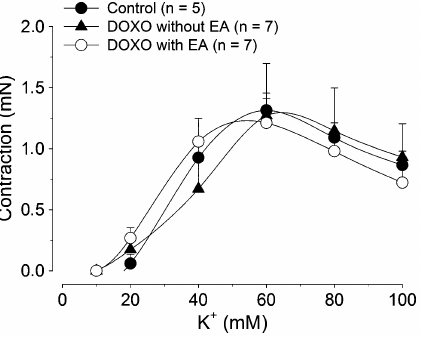
Figure 2. Comparison of the effect of KCl on the distal esophagus of fetus with esophageal atresia (EA). The graph shows the mean tension of the distal esophageal strips in response to increasing concentrations of KCl (10-100 mM). The tension was verified considering difference in peak and the amplitude expressed in mN. Data are reported as means±SE. DOXO: doxorubicin. There were no statistical differences in contractile activity in response to KCl comparing treated groups to controls (P . 0.05, two-way ANOVA, followed by a Student- Newman-Keuls test).